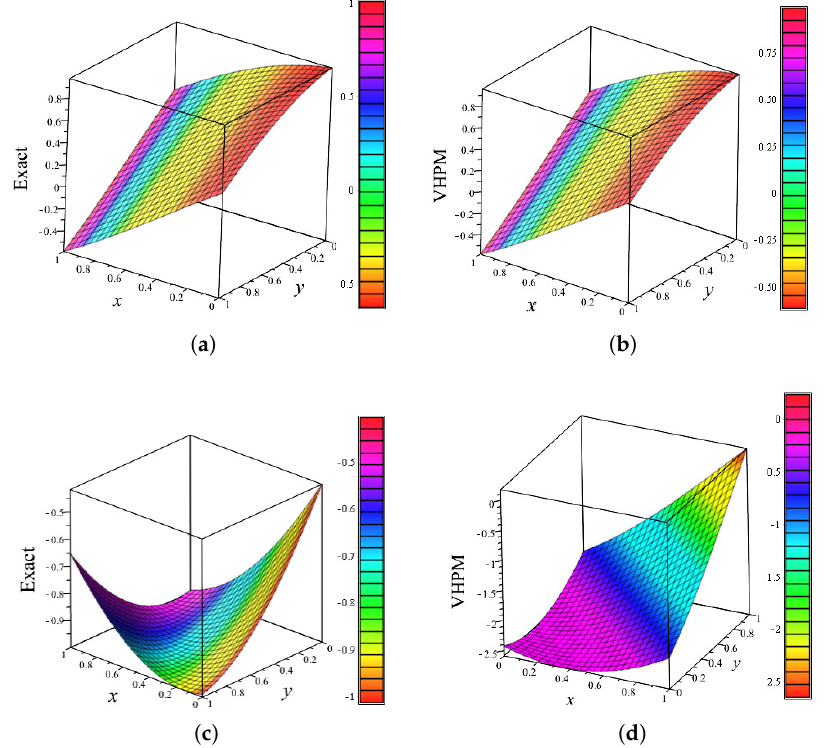
Figure 13. 3D graphical representation of the exact solution and approximate solutions vs. x vs. y using n = 7 terms from VHPM for Equation (9) at times t = 0.10, 1.0, respectively. ( a ) t = 0.10; ( b ) t = 0.10; ( c ) t = 1.0; ( d ) t =